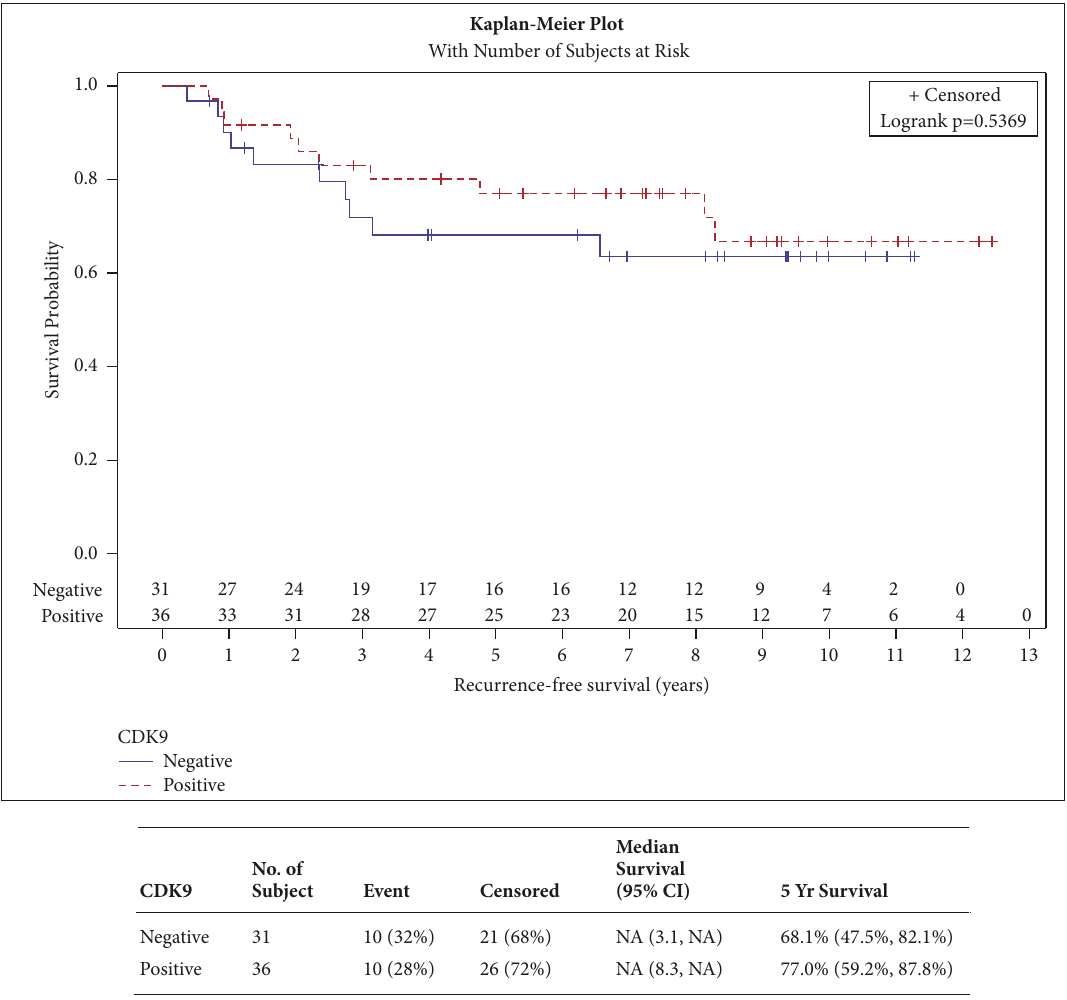
Figure 4: R ecurrence-free survival . Figure 4 shows curves comparing recurrence-freesurvival in patients with CDK9 positive versus CDK9 negative tumors. There is no statistically significant or observable difference in the two survival